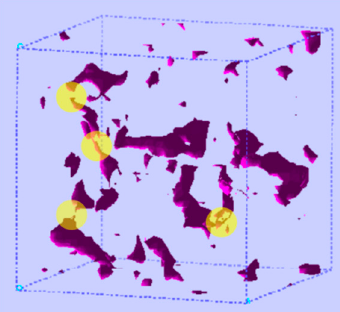
Figure 5. Indicative narrow-necking regions in the accessible volume obtained from geometric analysis, which serve as initial estimates for the transition state search calculations [33] . The simulated polymer is a poly(amide imide) in a cubic box of edge length 28.09 Å with periodic boundary conditions. Atoms are not shown. The dark regions are clusters of accessible volume, as determined with a spherical probe of radius 1.1 Å. Necking regions are identified by probing the same configuration with a smaller probe radius. Some of the necking regions are indicatively highlighted in yellow.